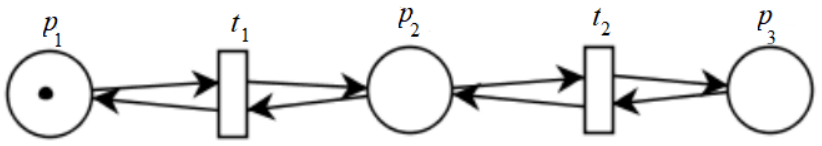
Figure 5. QPN model of a sequence of reversible